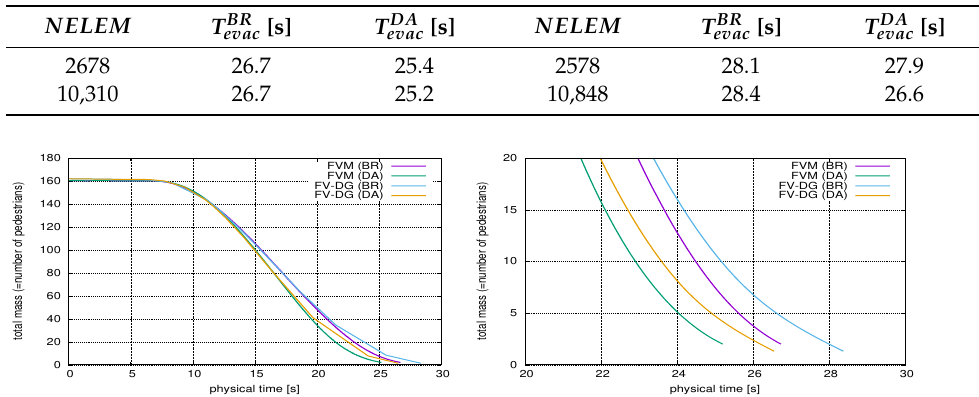
Table 4. T-shape domain, FV (left) and FV-DG (right), NELEM = # T h , T BR evac = evacuation time with